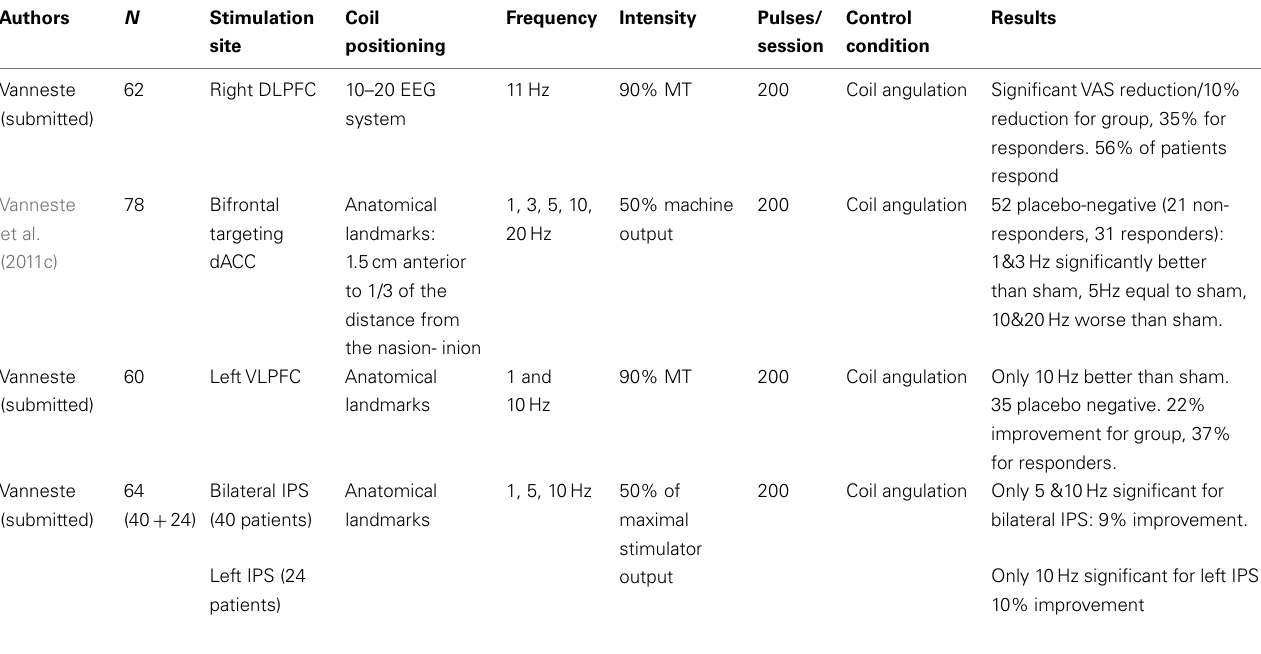
Table 4 | Effects of single sessions of rTMS over non-auditory brain areas.